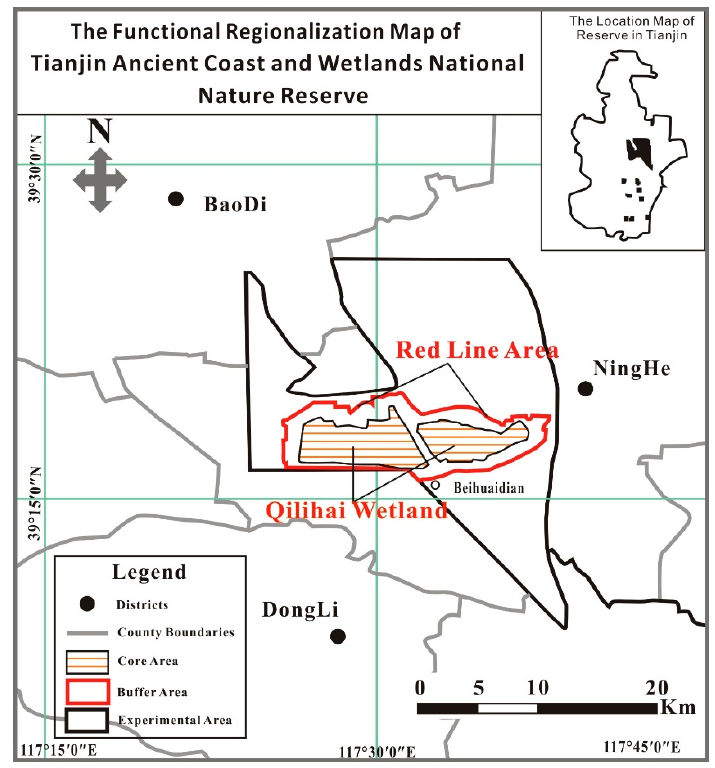
Figure 1. Map of the functional regionalization of the Tianjin Ancient Coast and Wetlands National Nature Reserve.